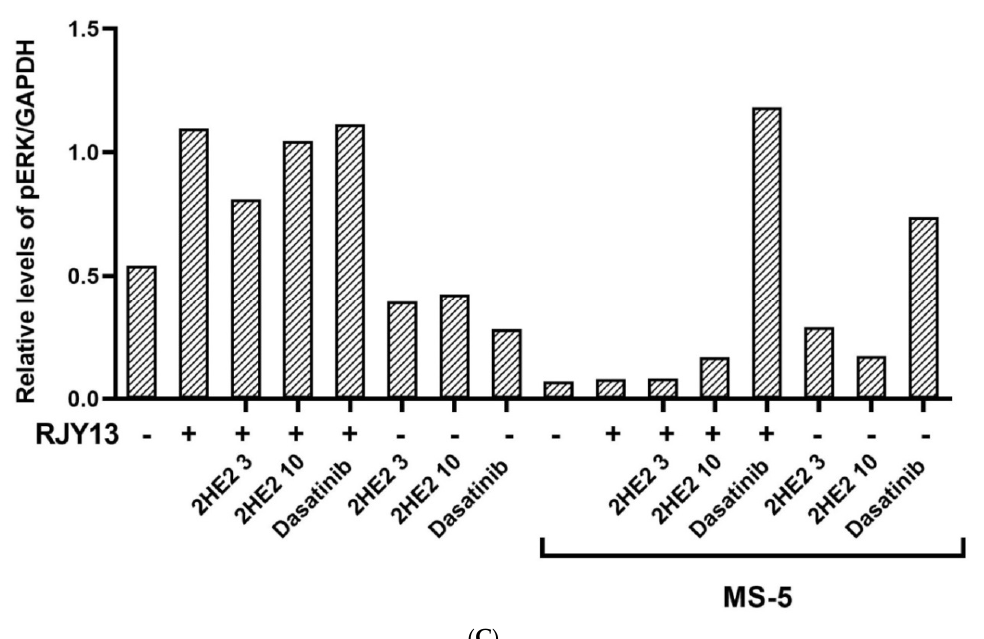
Figure 2. 2HE2 restored platinum sensitivity to OC cells independent of phospho-ERK1/2. ( A ) A2780CisR cells were treated with 2HE2 (3 and 10 μ M) and dasatinib (5 μ M) alone or in combination with RJY13 (5 μ M) and levels of cleaved PARP as well as phospho ERK1/2 were monitored by immunoblot. ( B ) A2780CisR cells co-cultured with MS-5 were treated with 2HE2 (3 and 10 μ M) and dasatinib (5 μ M) alone or in combination with RJY13 (5 μ M) and levels of cleaved PARP as well as phosphoERK1/2 were monitored by immunoblot. GAPDH was used as a loading control. ( C ) pERK1/2 levels relative to levels of GAPDH were calculated and blotted. The experiment was repeated twice with comparable outcomes.